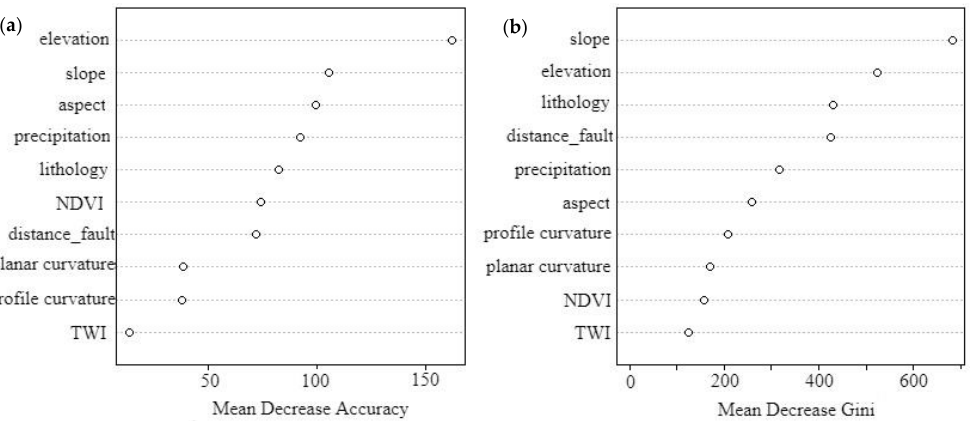
Figure 5. Random forest results: analysis of the relative importance of the variables. ( a ) is Mean Decrease Accuracy, ( b ) is Mean Decrease in Gini.